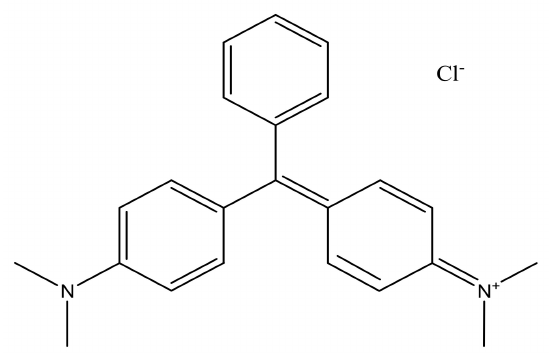
Figure 1. Chemical structure of malachite